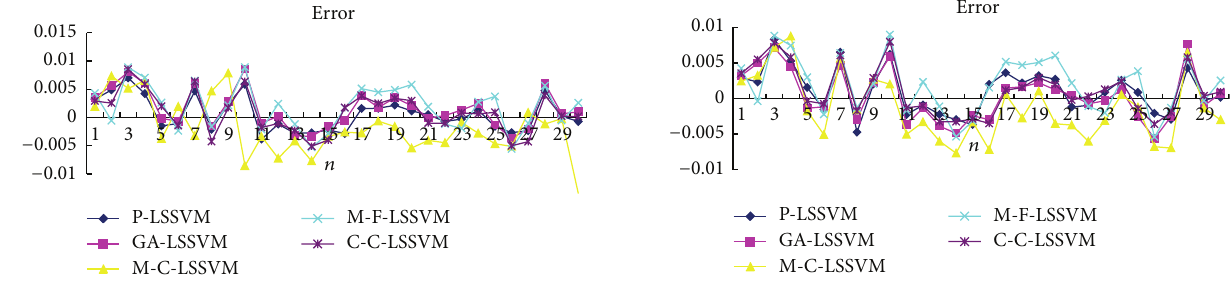
Figure 10: Five models predicted error diagram for interphone band.